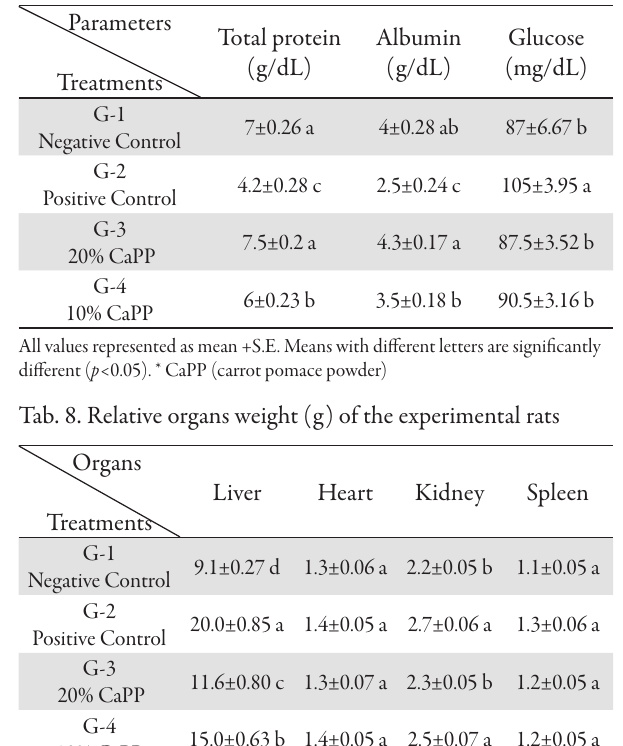
Tab. 7. Plasma protein, albumin (g/dL) and plasma glucose (mg/dL) of the experimental rats